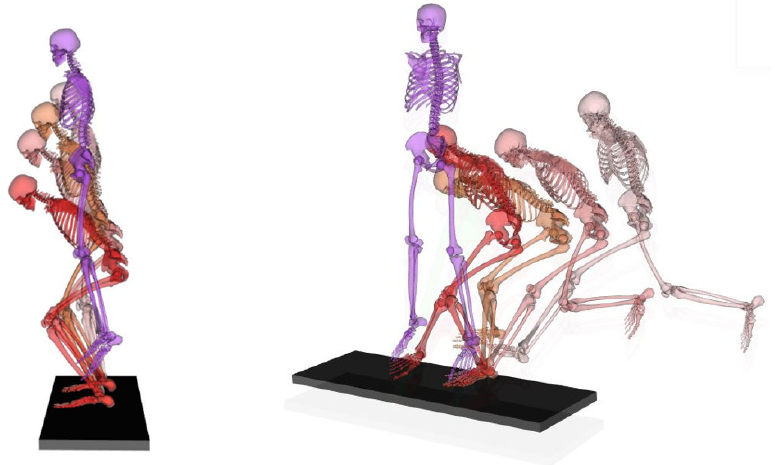
Figure 1. Illustration of movement sequence for the countermovement jump (CMJ: Left ) and pre- ferred style jump (PrefJ: Right ).